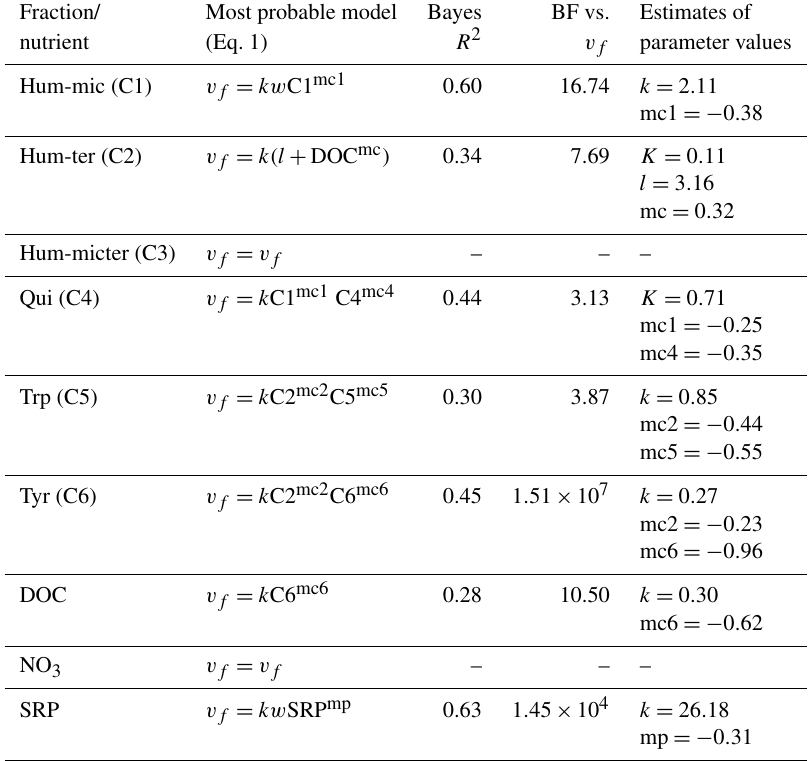
Table 6. Interactions between uptake velocity and concentrations of other nutrients or DOM components using the INSBIRE approach. v f : uptake velocity; k : uptake rate factor; w : wetted width; C i : fluorescence of PARAFAC components; m i : exponent of relation; l : additive